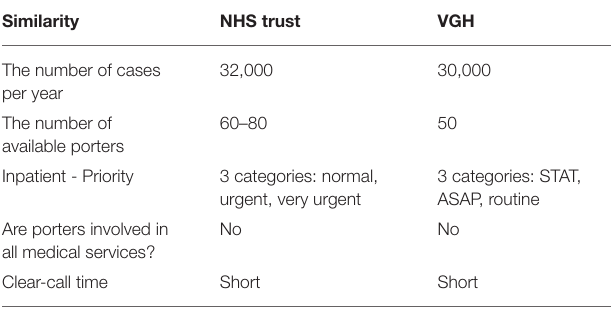
TABLE 1 | Illustration of the similarities of NHS Trust and VGH. Similarity